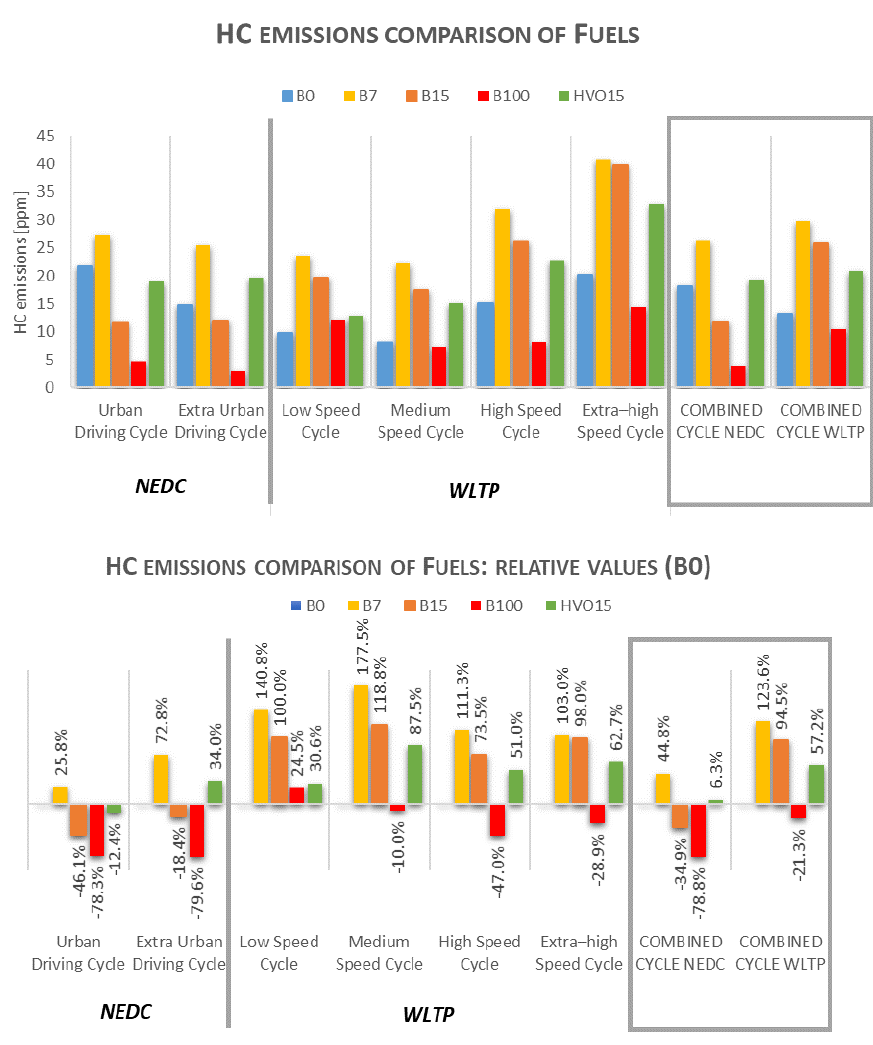
Figure 4. HC emission comparison of fuels, in total value and in percentage differences, in relation to the B0 fuel.